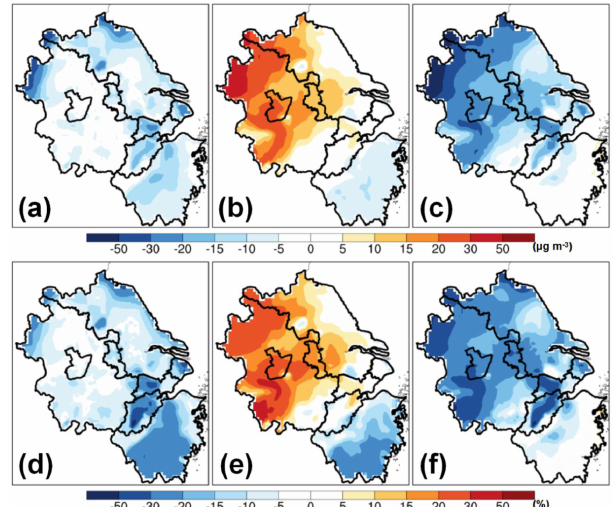
Figure 5. The impacts of anthropogenic emission controls and me- teorological variations on spatial PM 2 . 5 concentrations in January from 2016 to 2019. (a, d) Their net impacts. (b, e) Meteorologi- cal impacts. (c, f) The impacts of anthropogenic emission controls. Panels (a) – (c) and (d) – (f) refer to the changes in absolute values and relative percentages,